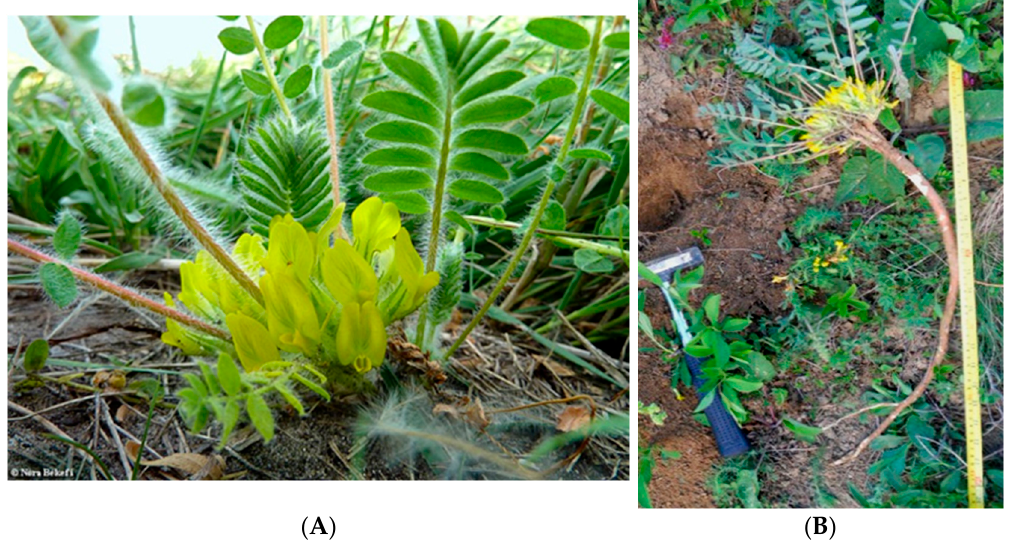
Figure 1. Astragalus exscapus ssp. transsilvanicus ( A ) aerial part ( B ) root system. Source: original